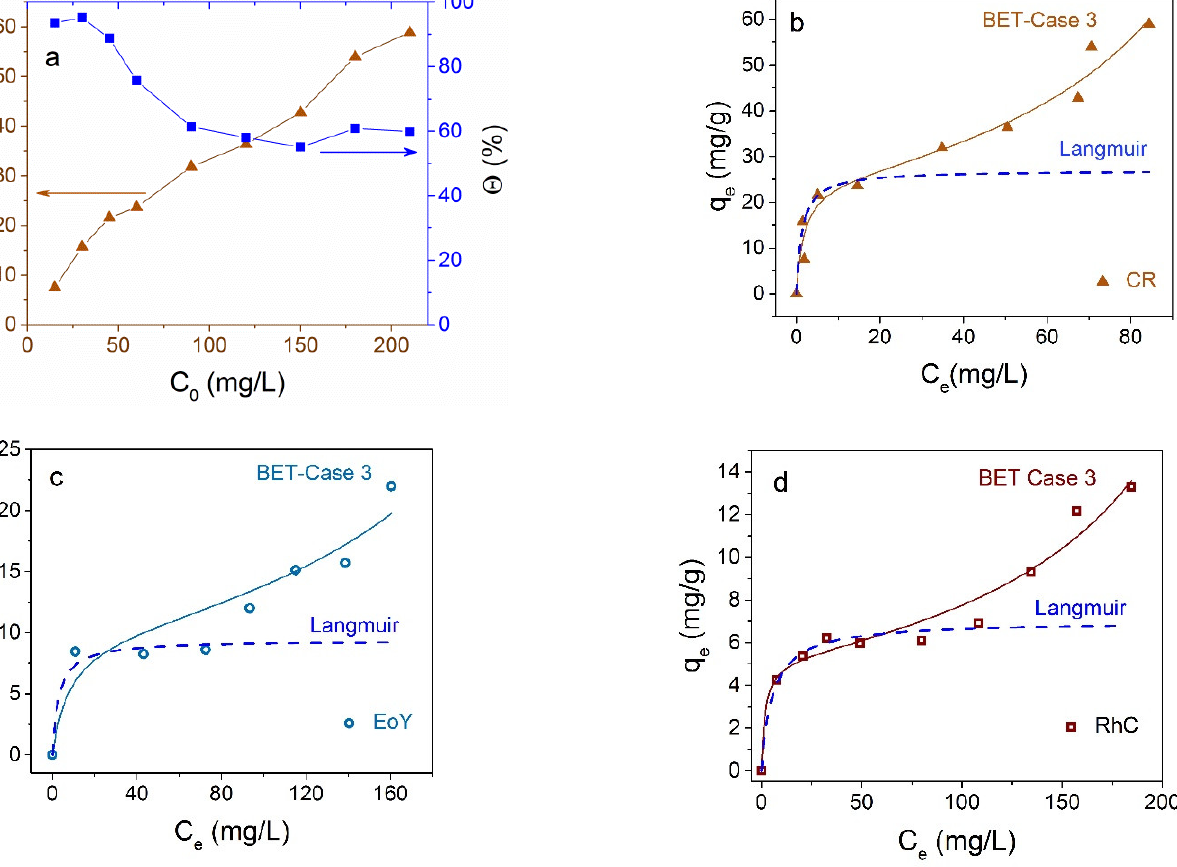
Figure 9. Adsorption isotherms of CR on Fe 3 O 4 NPs at 25 °C in depending on initial C 0 ( a ) and residual С e ( b ) dye concentration. The right axis in ( a ) shows the percentage of dye removal. Experimental adsorption isotherms of EoY ( c ) and RhC ( d ) are shown by circles and squares, correspondingly. Adsorption isotherms according to the BET and Langmuir models are shown in panels ( b – d ) by solid and dashed curves, correspondingly. Table 2. Calculated for CR parameters of isotherm for different adsorption models.